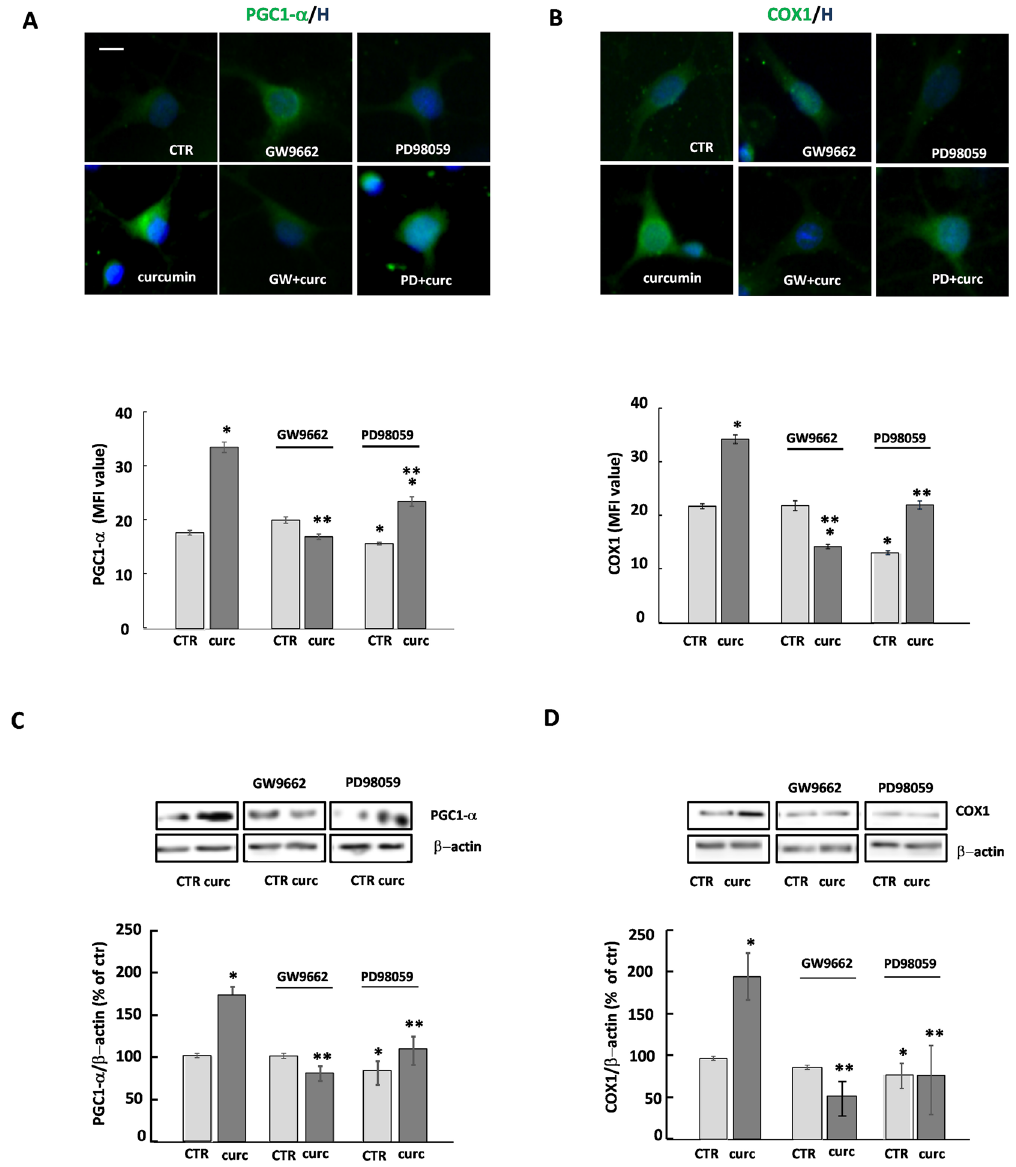
Figure 3. Curcumin induces the expression of PGC1-α and COX1. The expression of PGC1-α and COX1 was evaluated in OPs treated for 24 h with 1 μM curcumin (curc). To verify whether the effects of curcumin on PGC1-α and COX1 expression were PPAR-γ- and/or ERK-dependent, OPs were pretreated for 30 min with 1 μM GW9662 (GW; PPAR-γ antagonist) or 10 μM PD98059 (PD; ERK1/2 inhibitor). Representative photomicrographs of PCG1-α (panel A ; green) or COX1 (panel B ; green) are shown. Nuclei were stained using the Hoechst 33258 nuclear fluorochrome (blue, H). Mean fluorescence intensities (MFI value) are shown in the lower respective panels. Data are means ± SEM of 200–250 cells for condition. Western blot of PCG1-α and COX1 expression are shown in C and D , respectively. Representative western blot from same gel of PCG1-α or COX1 and β-actin (used as an internal control) are shown. Data are means ± SEM of three independent experiments (* p < 0.001 vs. CTR; ** p < 0.01 vs .curc). Scale bar 10 µm. Image Lab 4.0 software (Bio-Rad, http:// www.bio-rad.com/en-us/sku/17096 90-image -lab-softw are) and Leica Application Suite Software (260RI, https: //www.leica -micro syste ms.com/produ cts/micro scope -softw are/detai ls/produ ct/leica -las-x-ls/) were used respectively for Wb and IF image